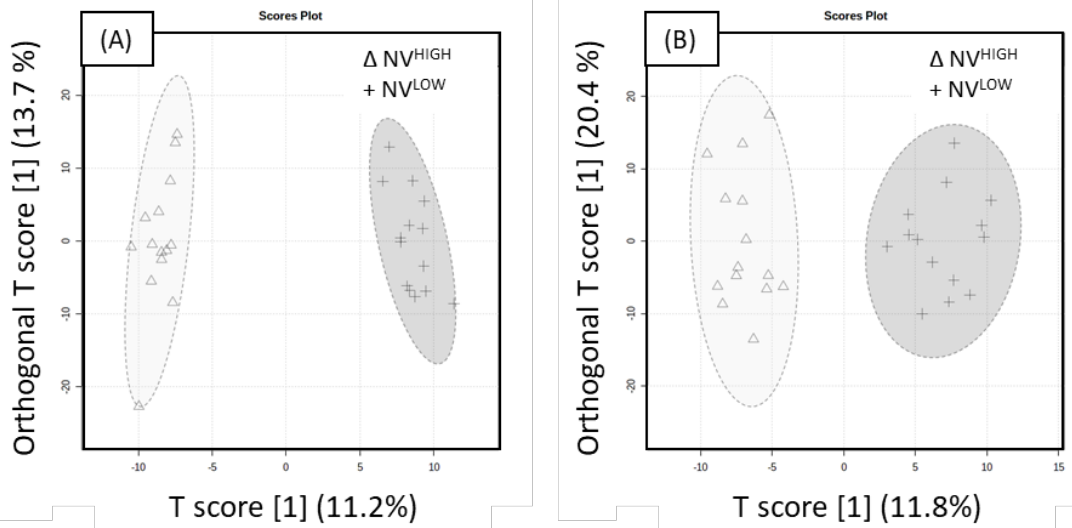
Figure 3. Orthogonal partial least squares discriminant analysis (OPLS-DA) of NV LOW and NV HIGH extracts acquired in UHPLC-HRMS. NV LOW (+) and NV HIGH ( ∆ ) OPLS-DA score plot for ( A ) ESI+ mode with an associated 95% confidence ellipses (Q 2 = 0.601, R 2 Y = 0.724) and ( B ) ESI- mode with an associated 95% confidence ellipses (Q 2 = 0.568, R 2 Y = 0.709). Both models were significant indicated by 100 different model permutations for ( A ) ( p < 0.01, Q 2 = 0.807 and R 2 Y = 0.983) and ( B ) ( p < 0.01, Q 2 = 0.816 and R 2 Y = 0.934).